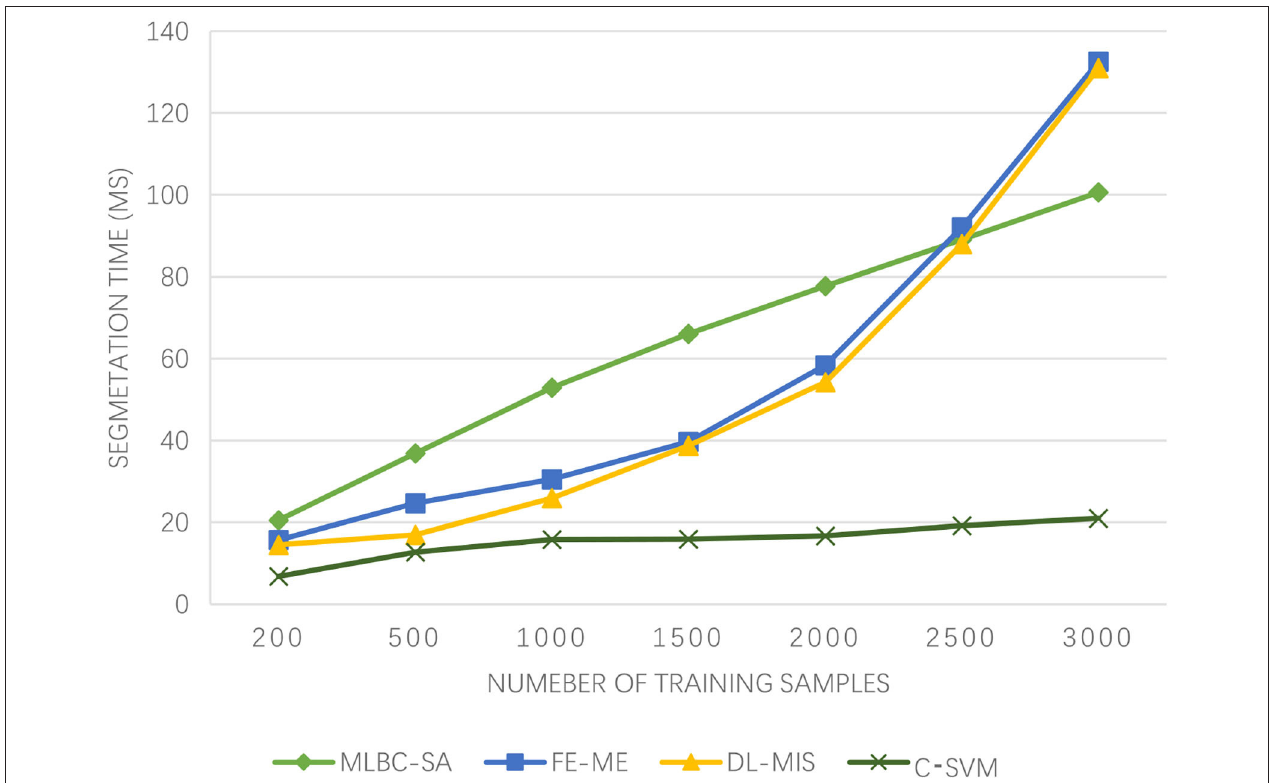
FIGURE 2 | Experimental results of segmentation